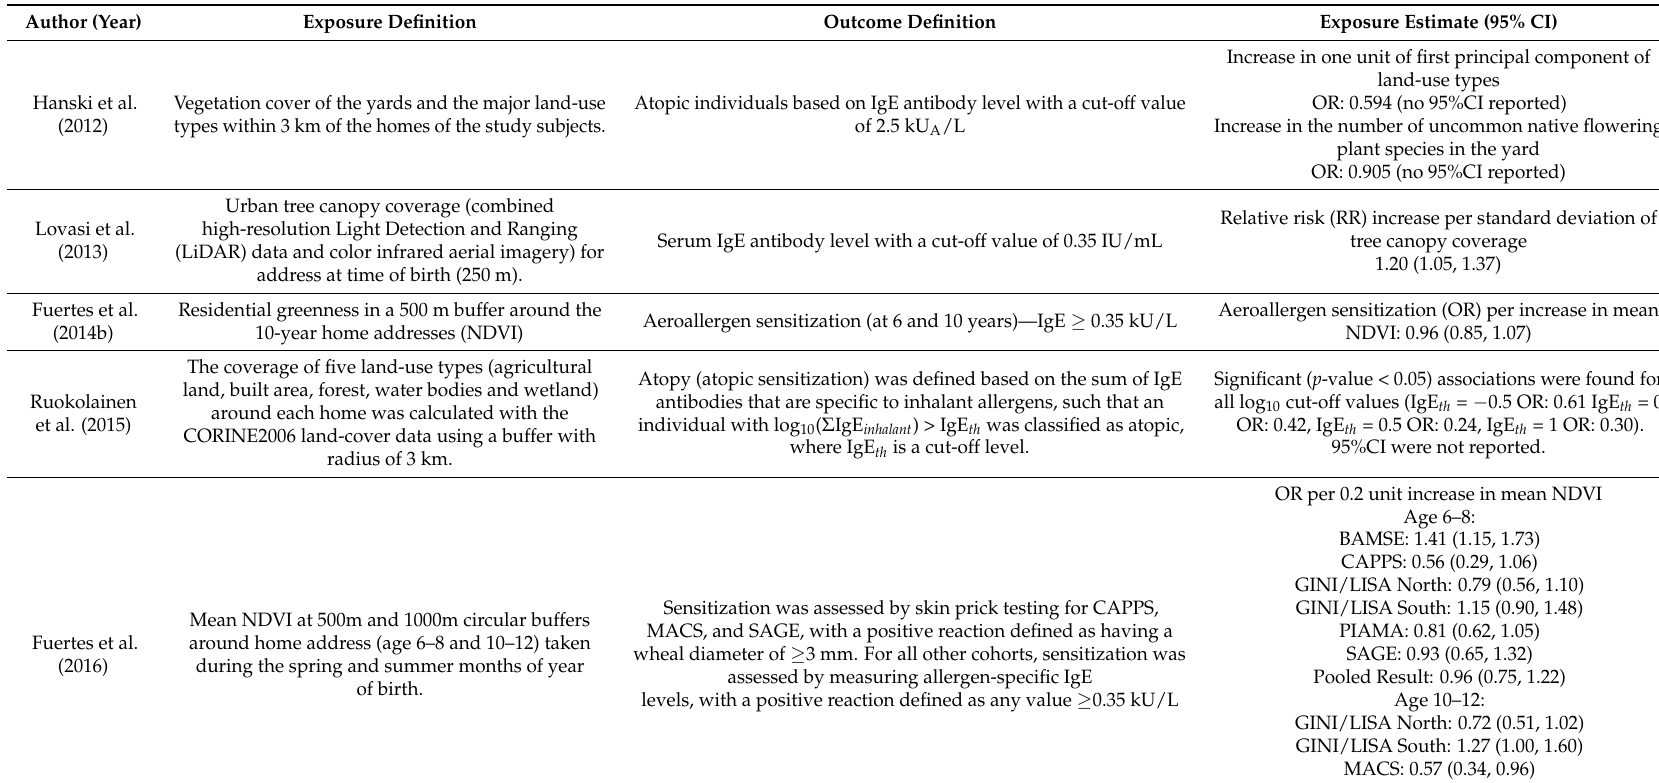
Table 2. Detailed characteristics of studies examining effect of residential greenness on outcomes related to atopic sensation.